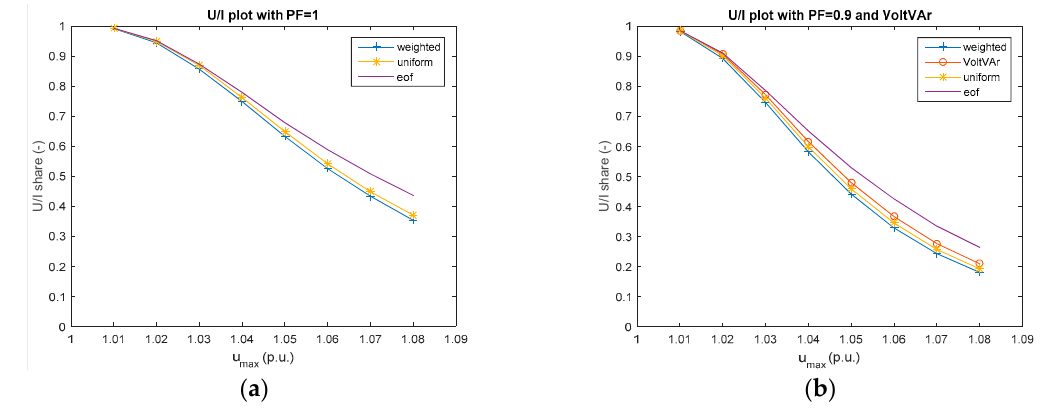
Figure 17. Share of voltage- and current-constrained feeders. u max = [1.01–1.08] p.u. – I max = 100% DER scenario: uniform, end of feeder, weighted-and a power factor of 1. ( a ) PF = 1; and ( b ) PF = 0.9 and VoltVAr. The DER-scenario uniform was applied for the case VoltVAr.